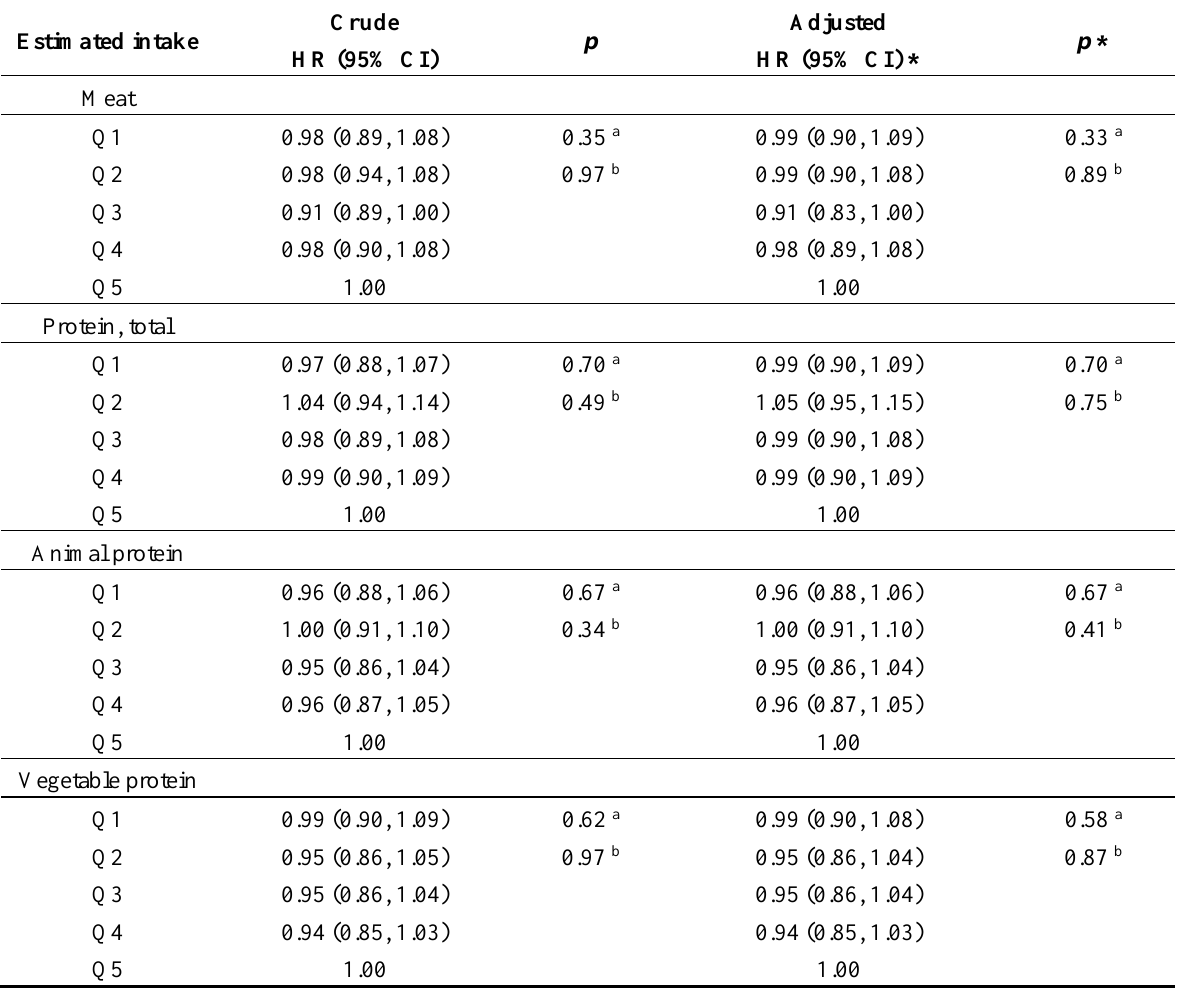
Table 5. Hazard ratios (HRs) of offspring forearm fractures in the Danish National Birth Cohort according to maternal dietary intakes of meat and protein in mid-pregnancy ( n =